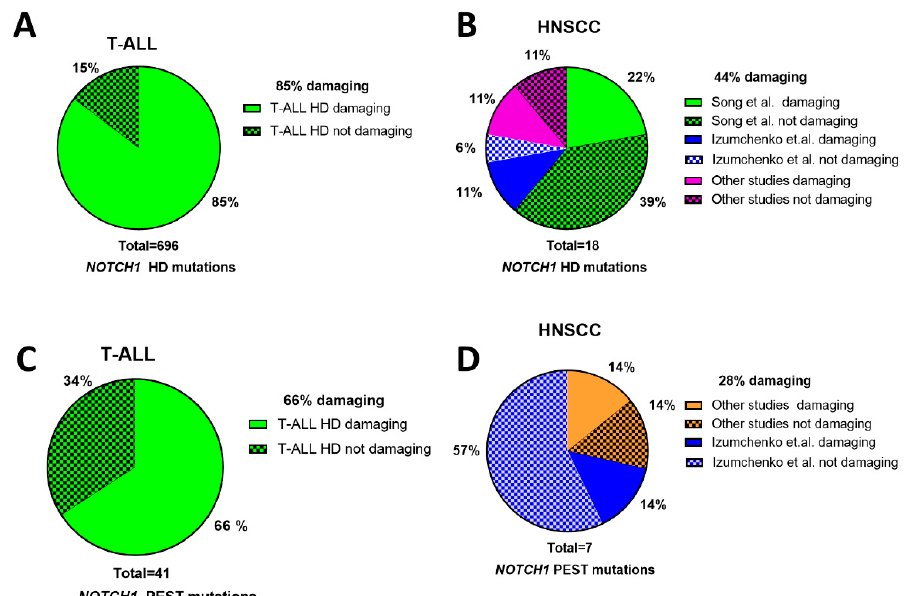
Figure 4. Predicted impact of NOTCH1 missense mutations from the HD and PEST domains. NOTCH1 missensemutationsoccurringintheHDdomainforT-ALL( A )orHNSCC( B )withproportionspredicted to be impactful by PROVEAN or SIFT (solid pattern) or tolerated (checkered pattern). NOTCH1 missense mutations occurring in the PEST domain for T-ALL ( C ) or HNSCC ( D ) with proportions predicted to be impactful by PROVEAN or SIFT (solid pattern) or tolerated (checkered